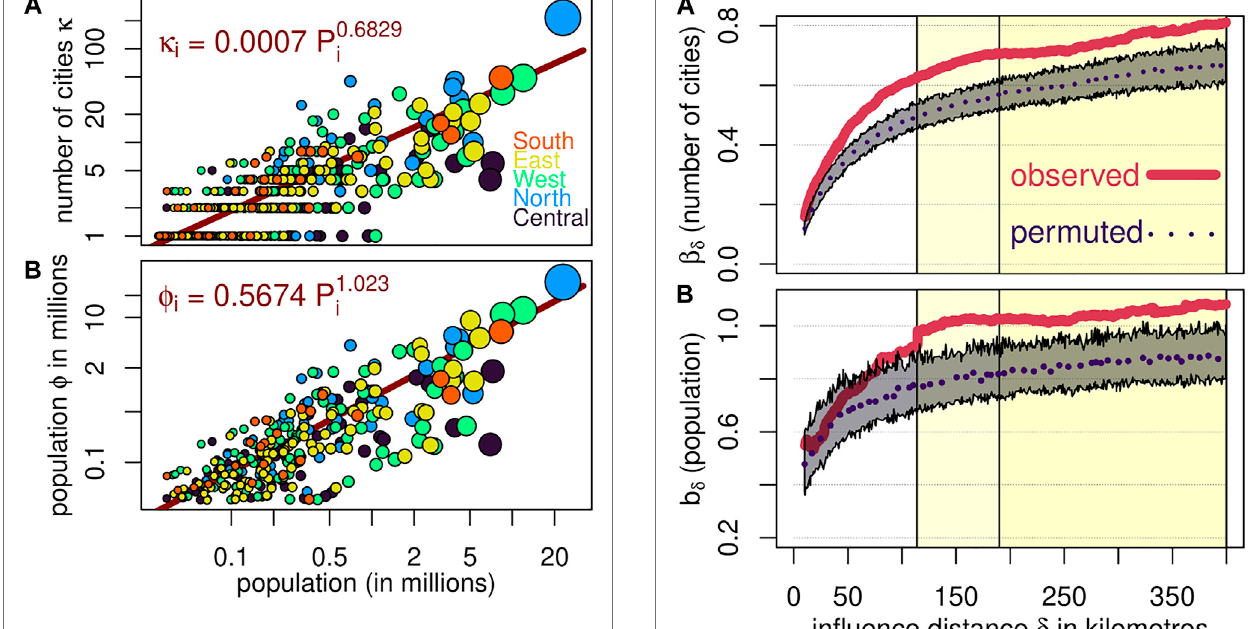
FIGURE 4 | Number of cities κ (155) inside regions of in fl uence (A) and population inside the region of in fl uence (ignoring the population from the centre) ϕ (155) (B) against city size (horizontal axis). Axis have a logarithmic scale. Each city is represented by a coloured disc, with its size proportional to population. Five African regions are represented by the colour of the disc.